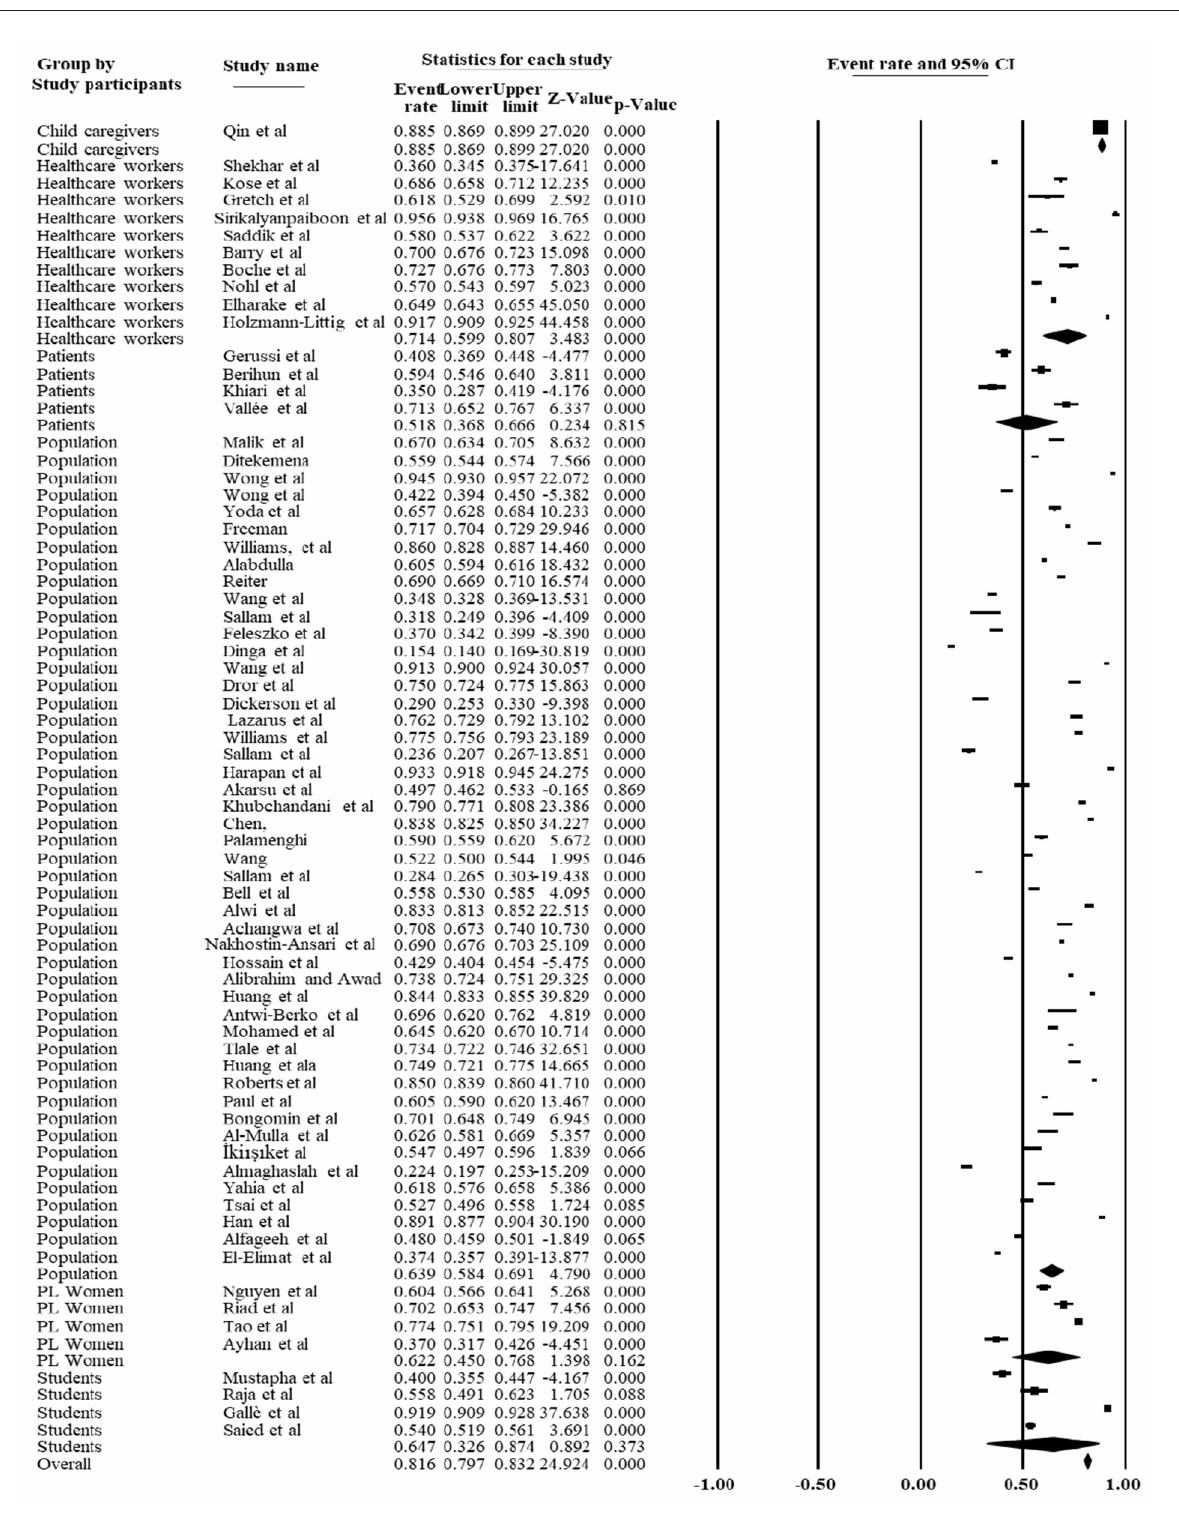
FIGURE7 Forest plot shows the subgroup analysis of the pooled COVID-19 vaccine rate based on the study participants,